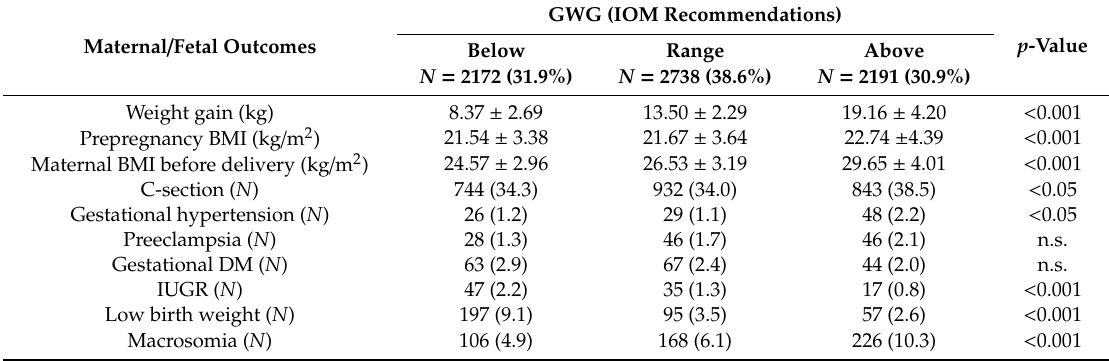
Table 3. Maternal / fetal outcomes associated with GWG (IOM recommendations).